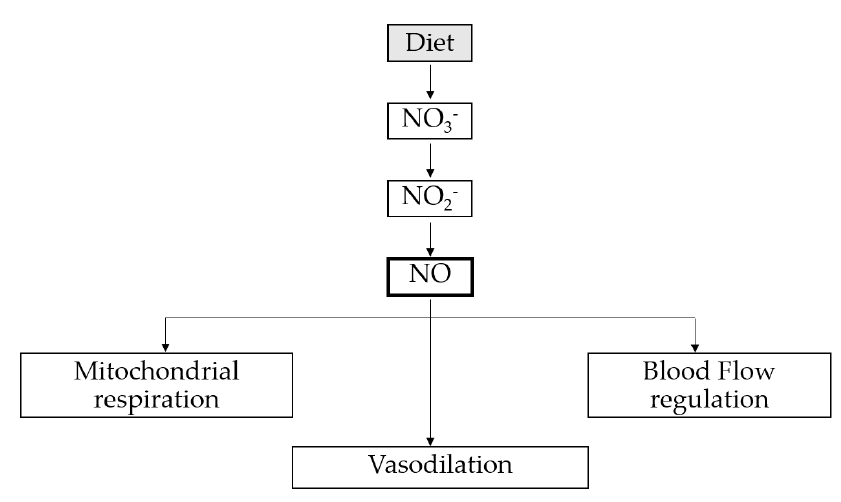
Figure 1. The main beneficial effects of nitric oxide on physical performance.